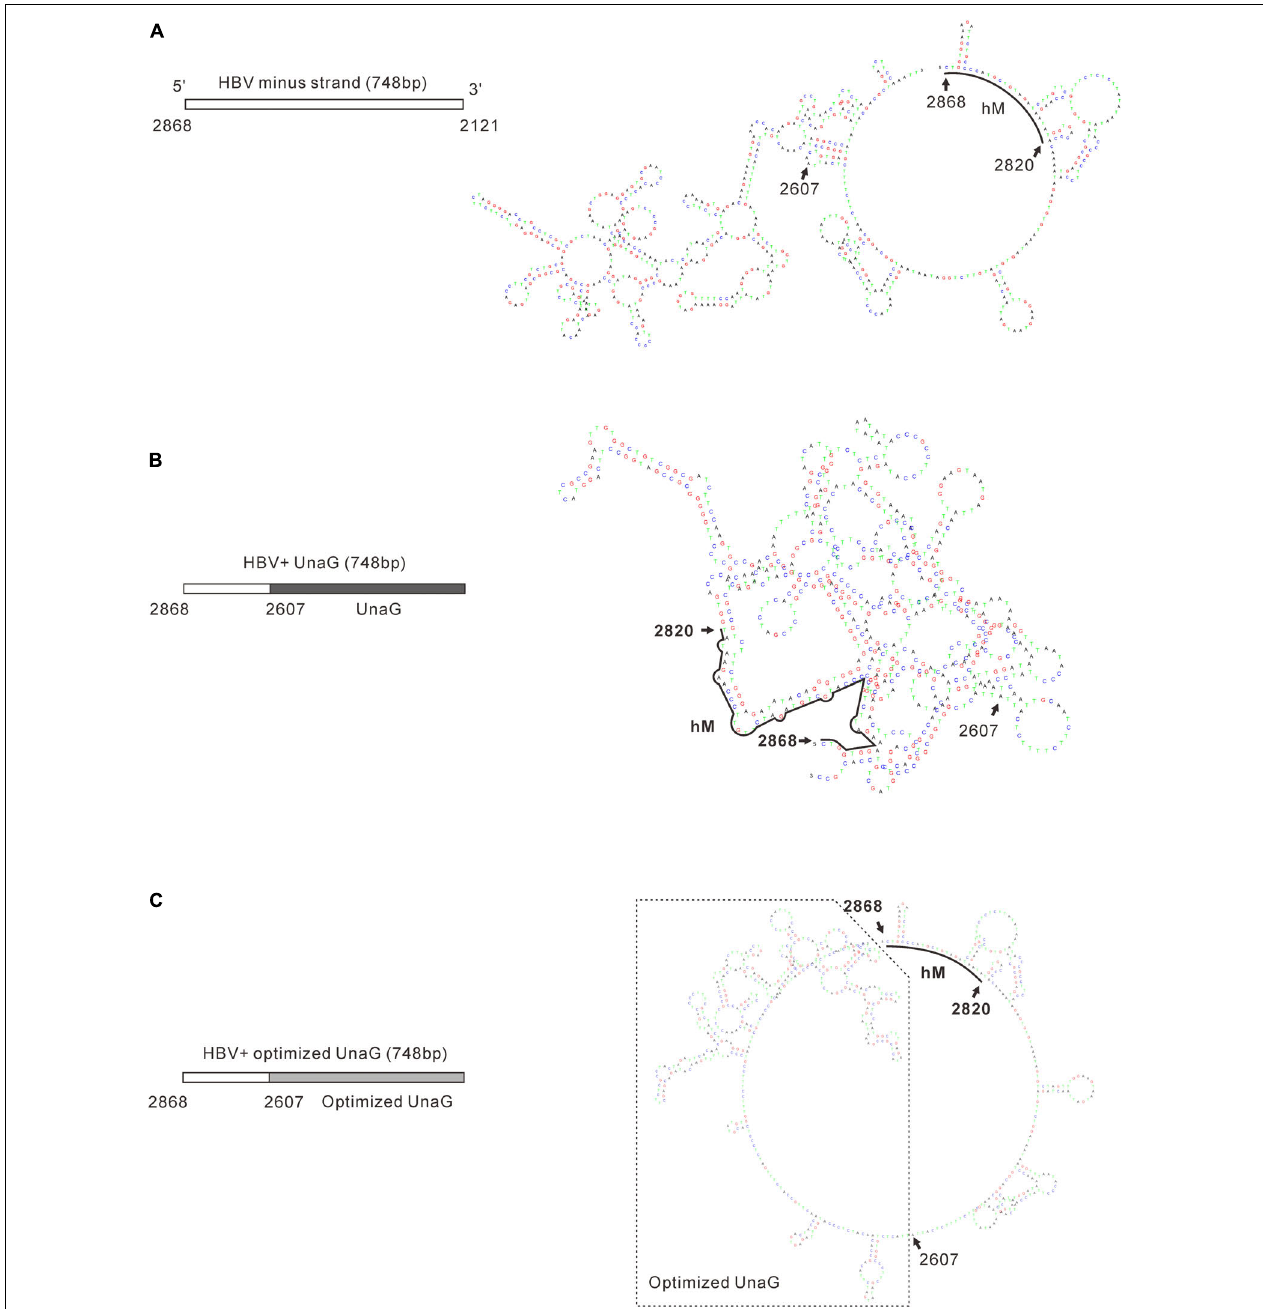
FIGURE 11 | Prediction of the secondary structure of minus-strand DNA of the recombinants. Secondary structures of the minus-strand DNA of wild-type HBV (A) , unoptimized UnaG recombinant (B) , and optimized UnaG (C) were predicated by using DNAMAN 8. The structure of cis -element hM (nt 2820–2868) is indicated. It is obvious that unoptimized UnaG profoundly affects the structure of HBV sequence, including hM. In contrast, optimized UnaG showed no significant impacts on the structure of the HBV sequence (nt